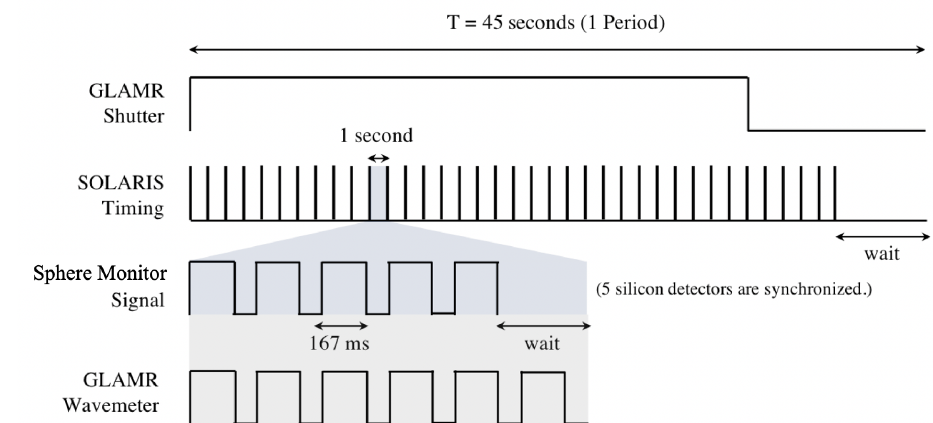
Figure 5. The time sequence of the data acquisition during SOLARIS GLAMR RadCal.